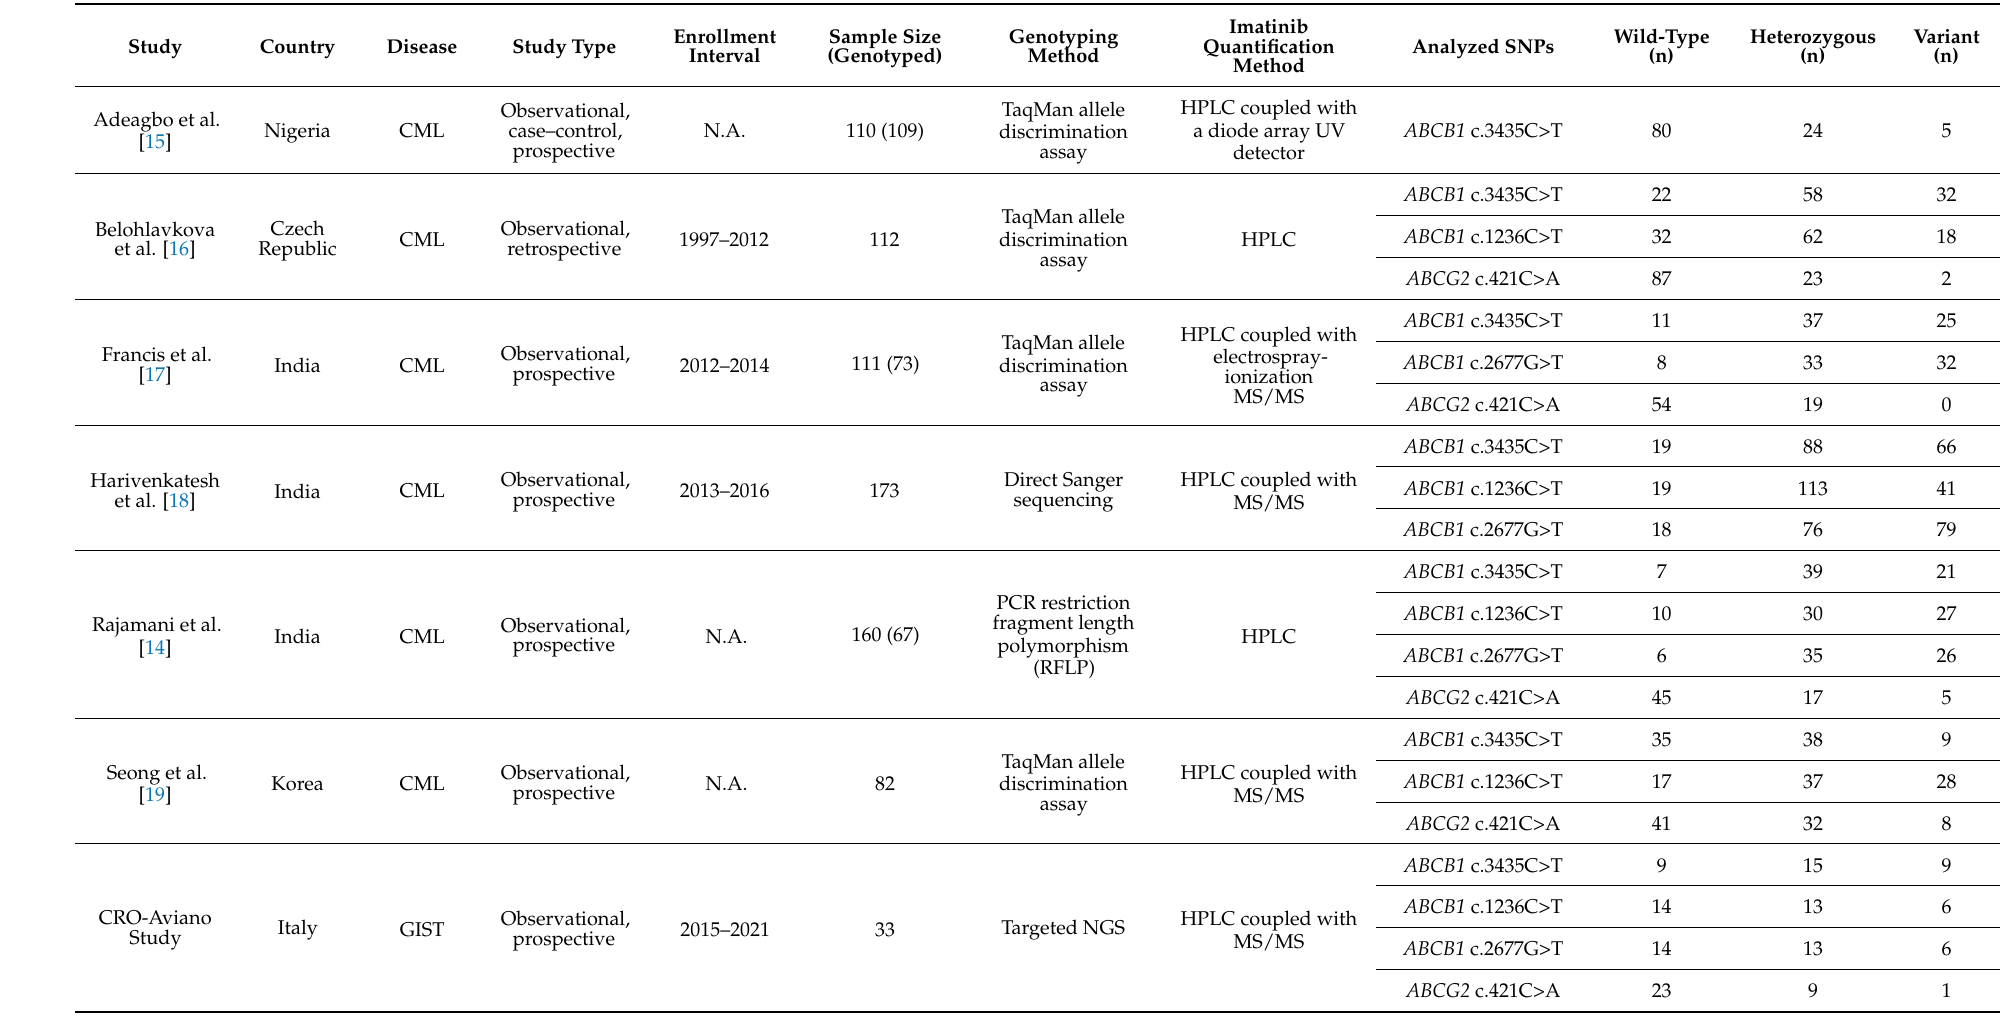
Table 4. Characteristics of the studies selected for the